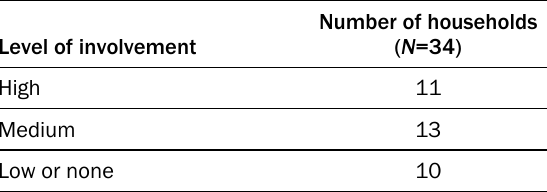
Table 2. Level of Involvement with Local